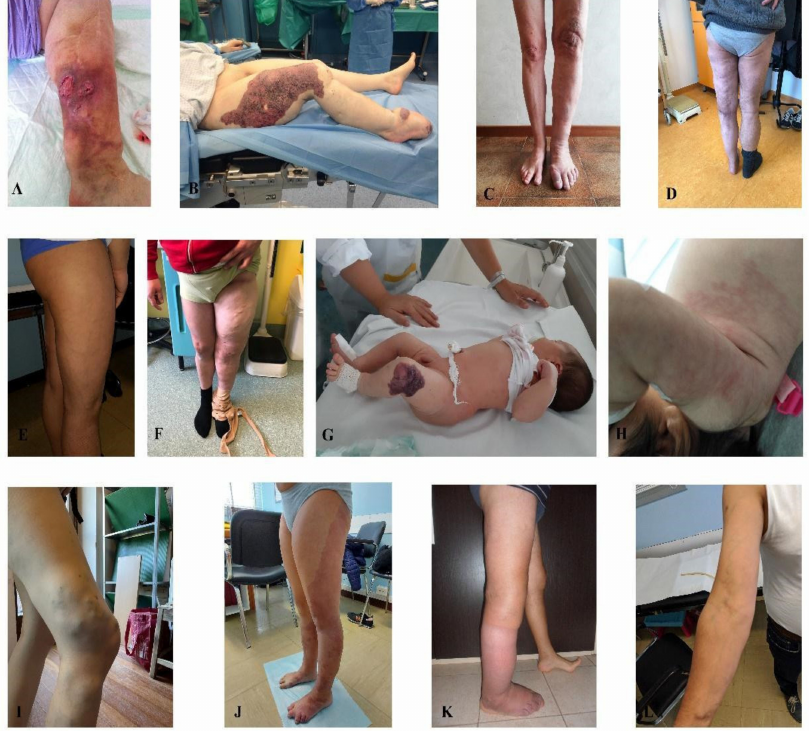
Figure 1. Klippel-Trenaunay syndrome. ( A ) patient 1, ( B ) patient 2, ( C ) patient 3, ( D ) patient 4, ( E ) patient 5, ( F ) patient 6, ( G ) patient 7, ( H ) patient 8, ( I ) patient 9, ( J ) patient 10, ( K ) patient 11, ( L ) patient